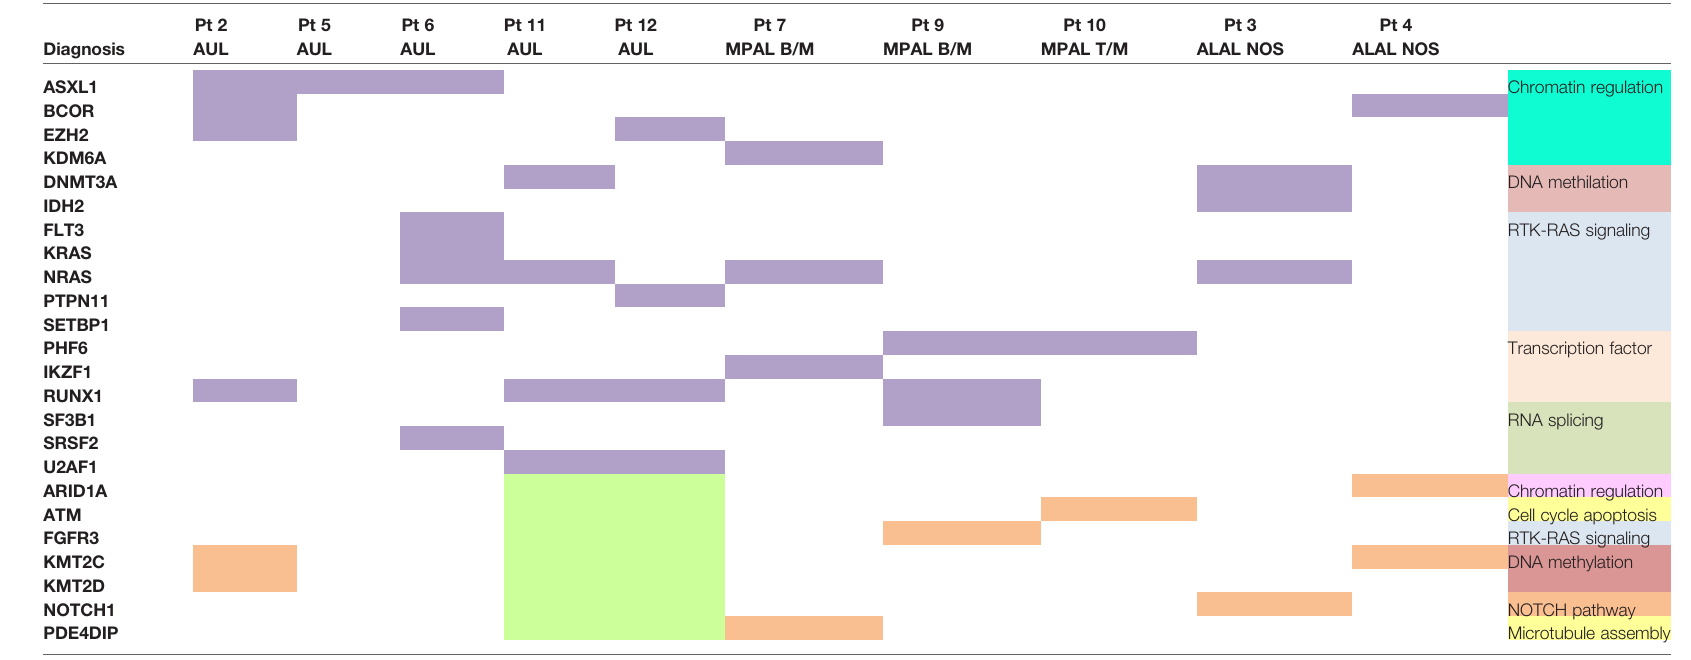
TABLE 2 | Mutational pro fi le of the 10 patients with acute leukemia of ambiguous